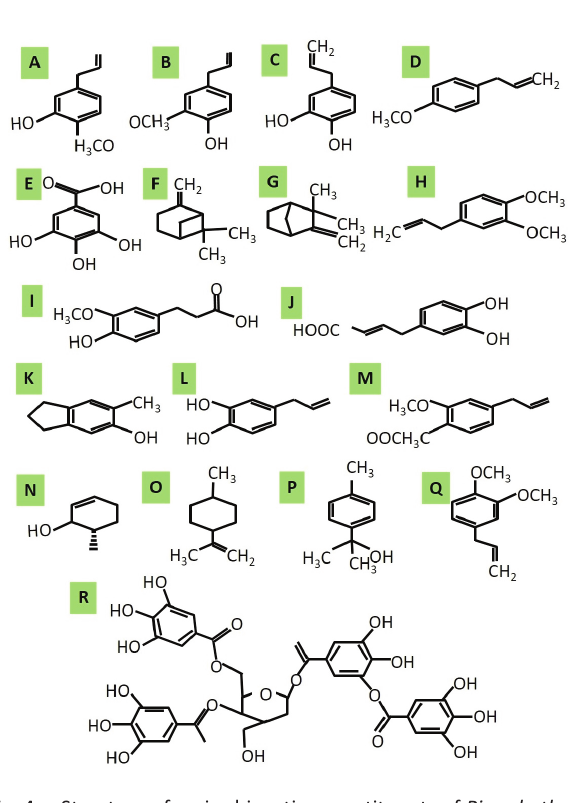
Fig. 4 ­ Structure of major bioactive constituents of Piper betle